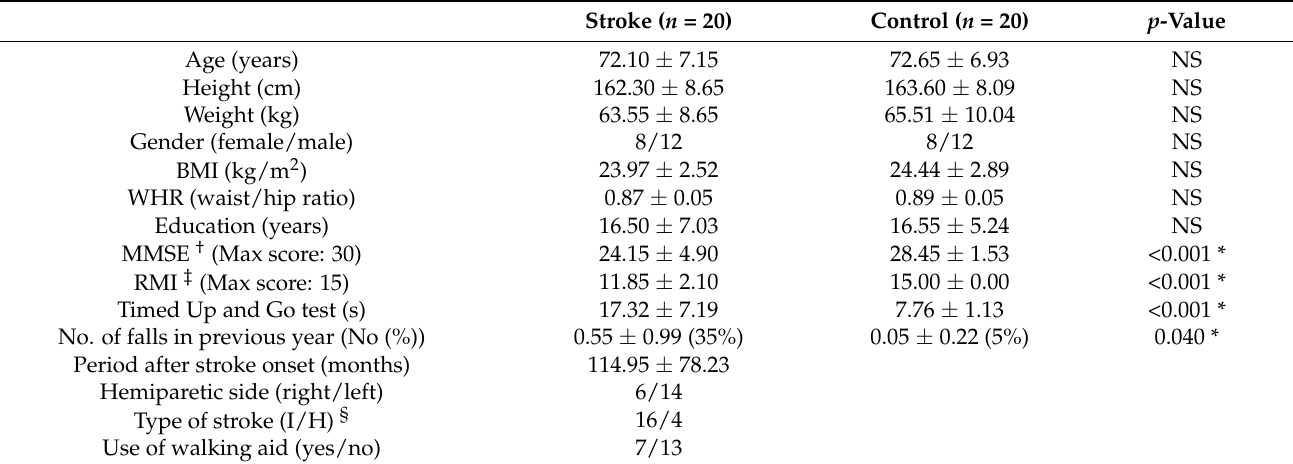
Table 1. Characteristics of patients in stroke and control